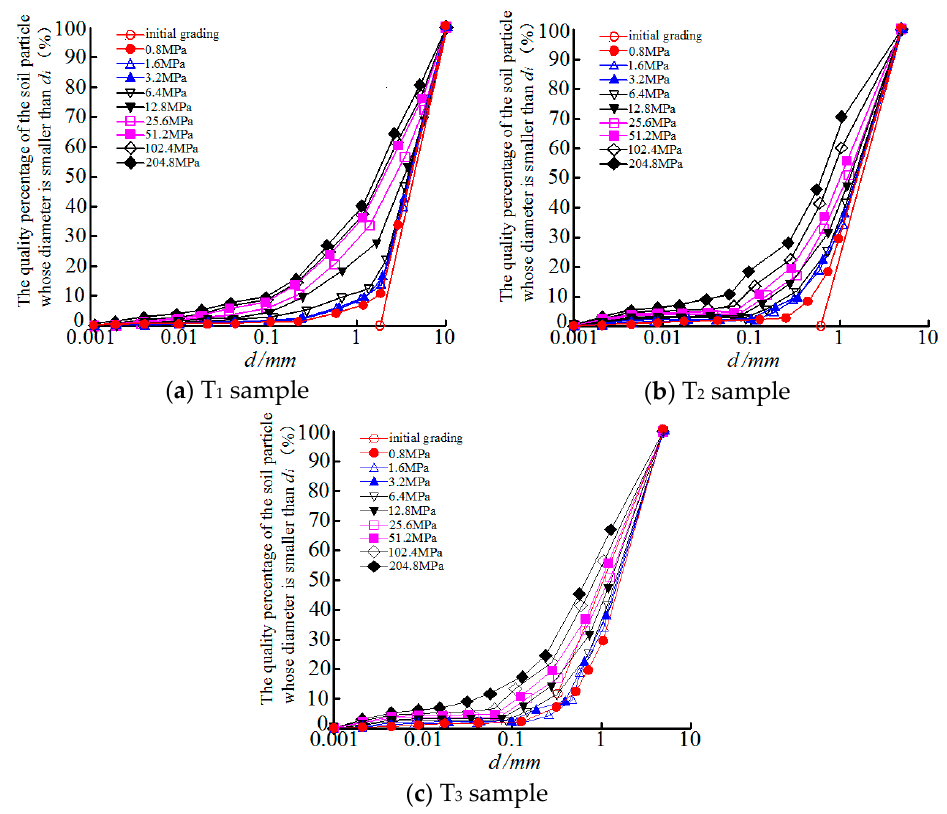
Figure 4. Evolution of particle size distributions (semi-logarithmic axes): ( a ) T1 sample, ( b ) T2 sample and ( c ) T3 sample.